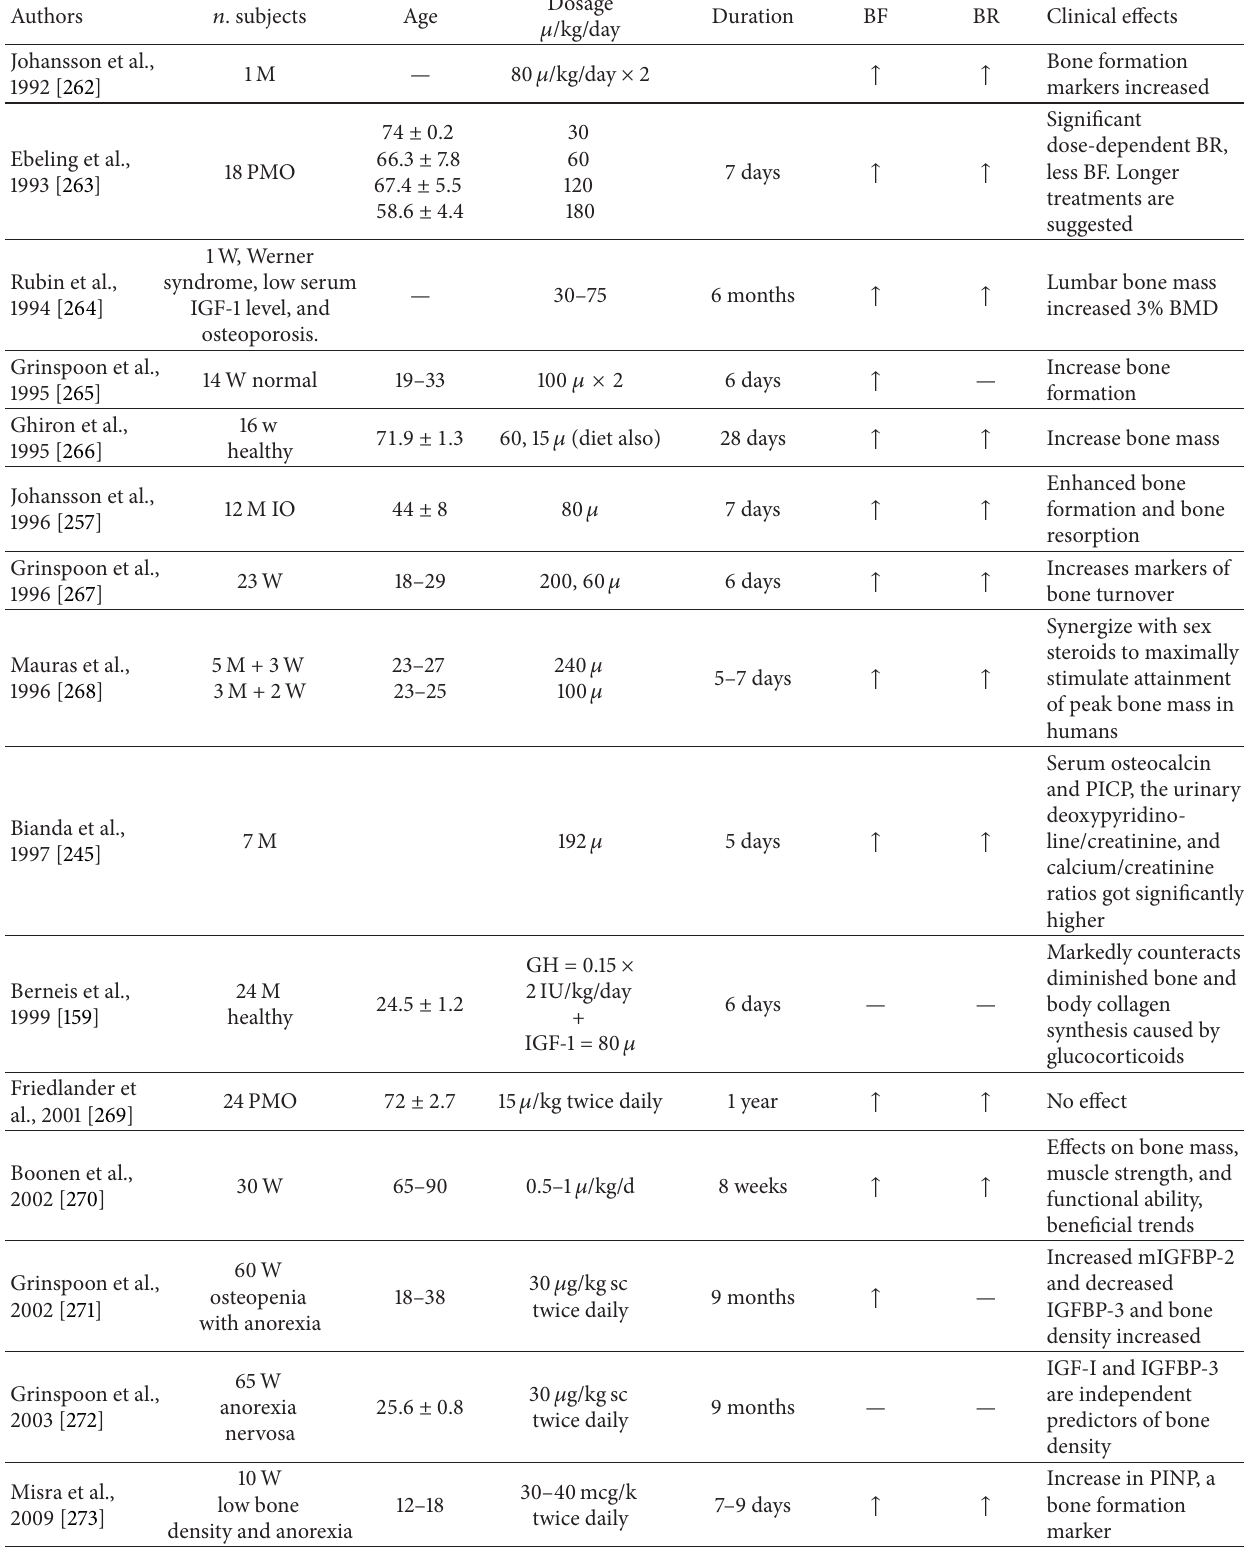
Table 2: Effect of IGF-1 administration on osteoporosis and bone